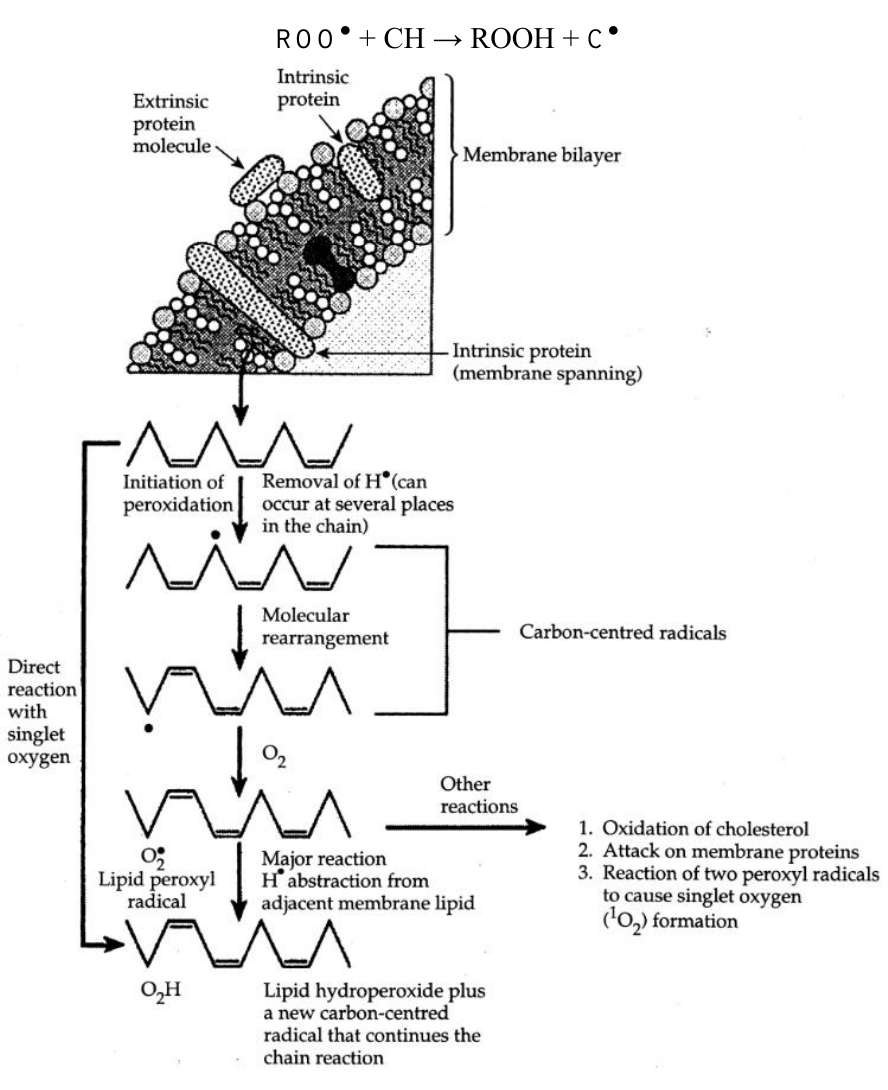
Figure 1. Idealized representation of the initiation and propagation reactions of lipid peroxidation. The peroxidation of fatty acids with three double bonds is shown. Reprinted from